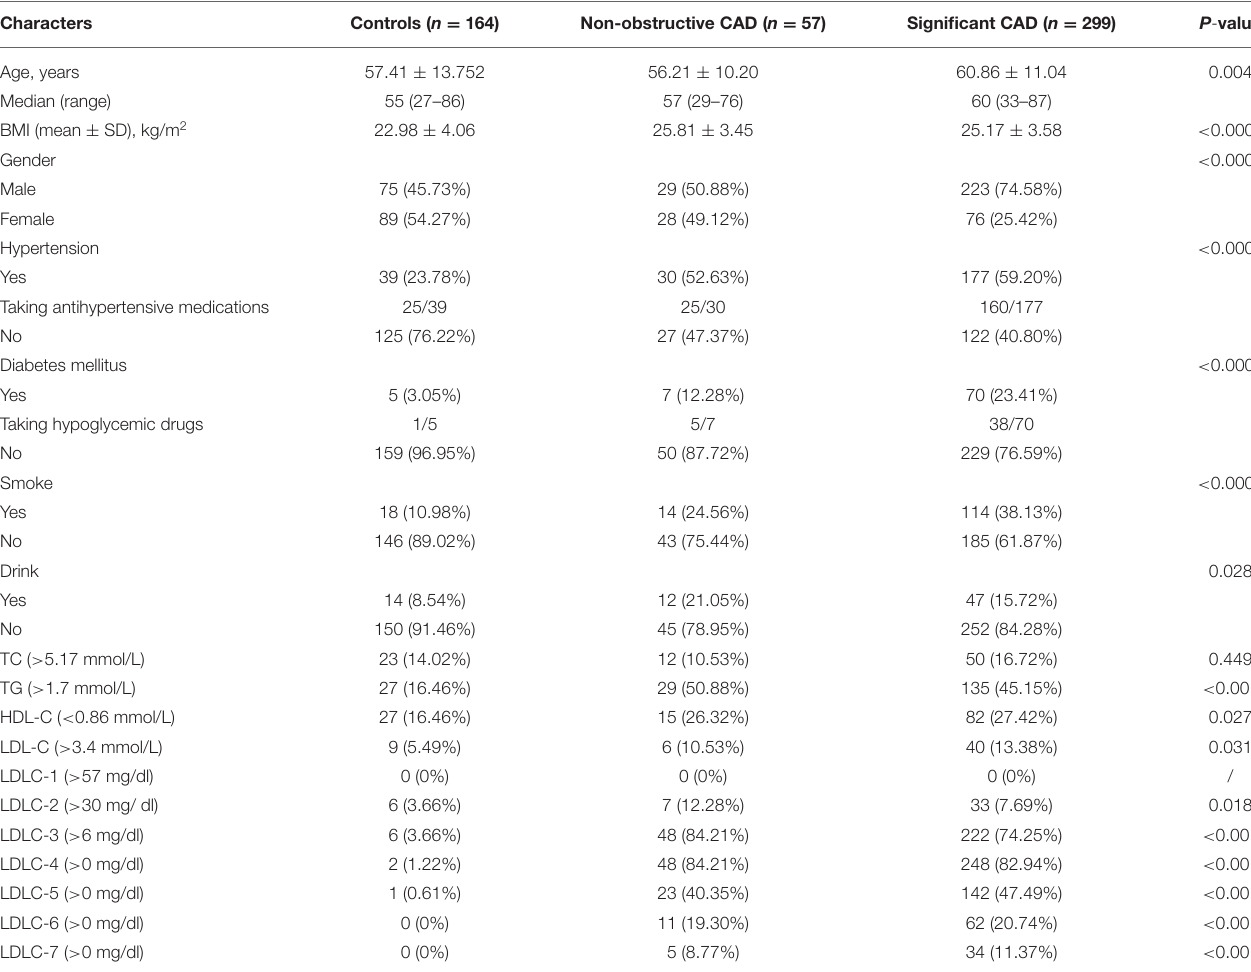
TABLE 1 | Clinical characteristics and blood lipids of controls and CAD